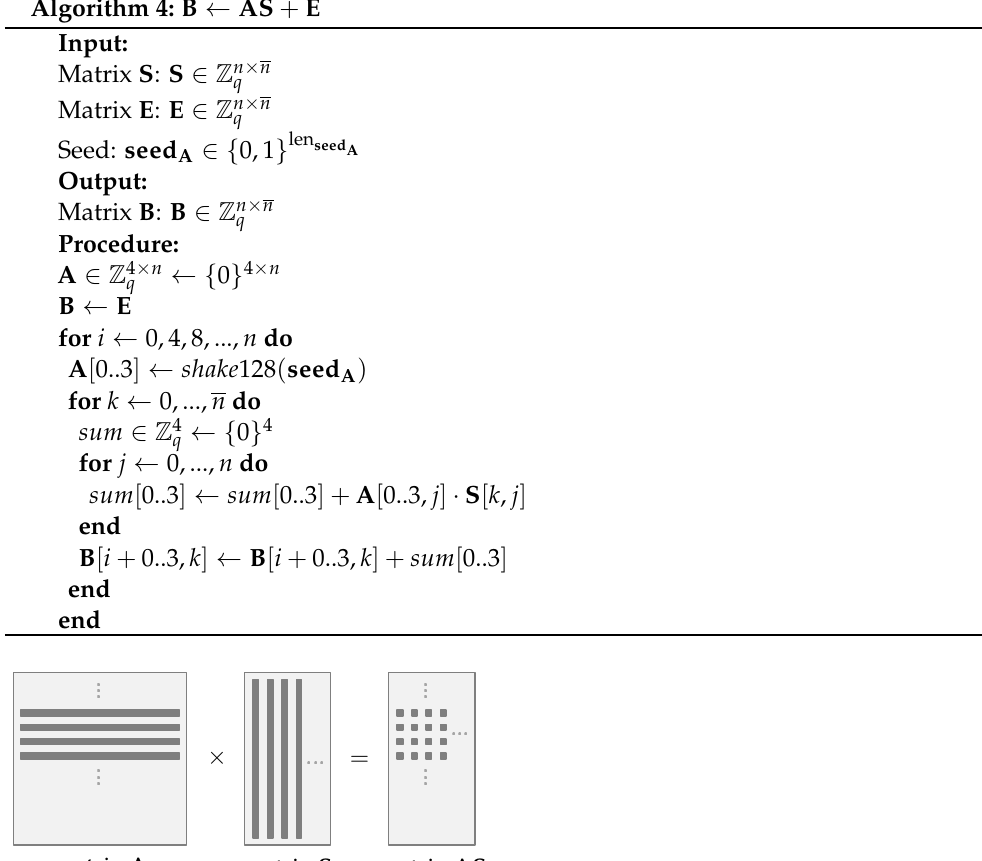
A S . Multiplication of four rows of the matrix A by matrix S . ← ×